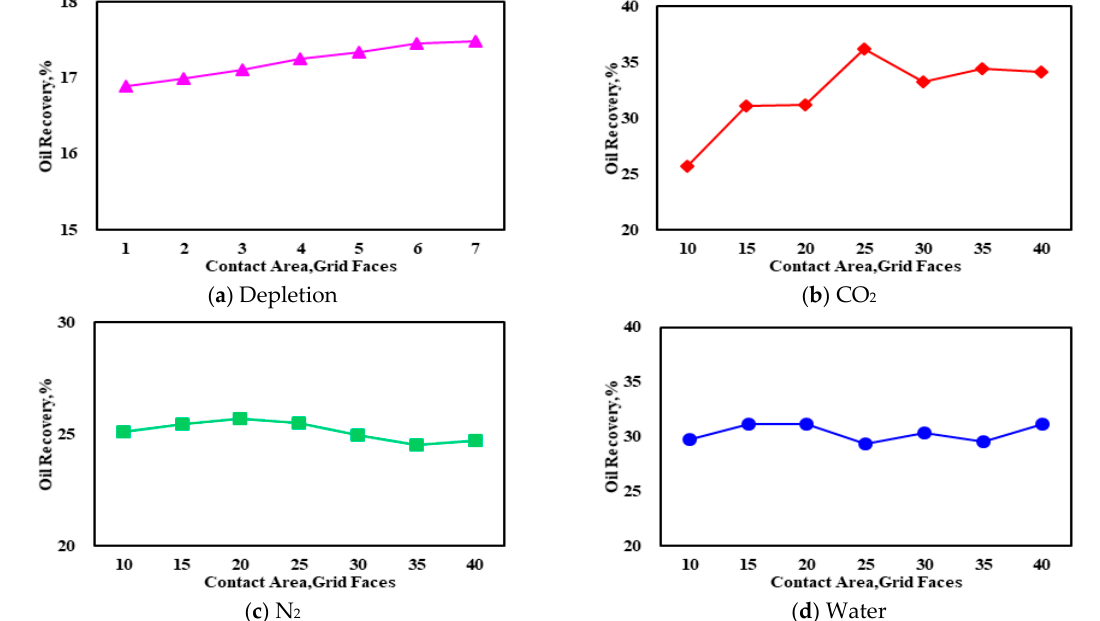
Figure 33. Relationship between contact area and oil recovery in different modes.